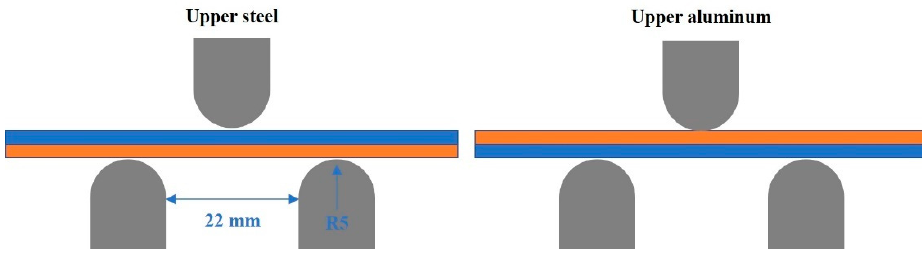
Figure 3. Structure of the bending test.